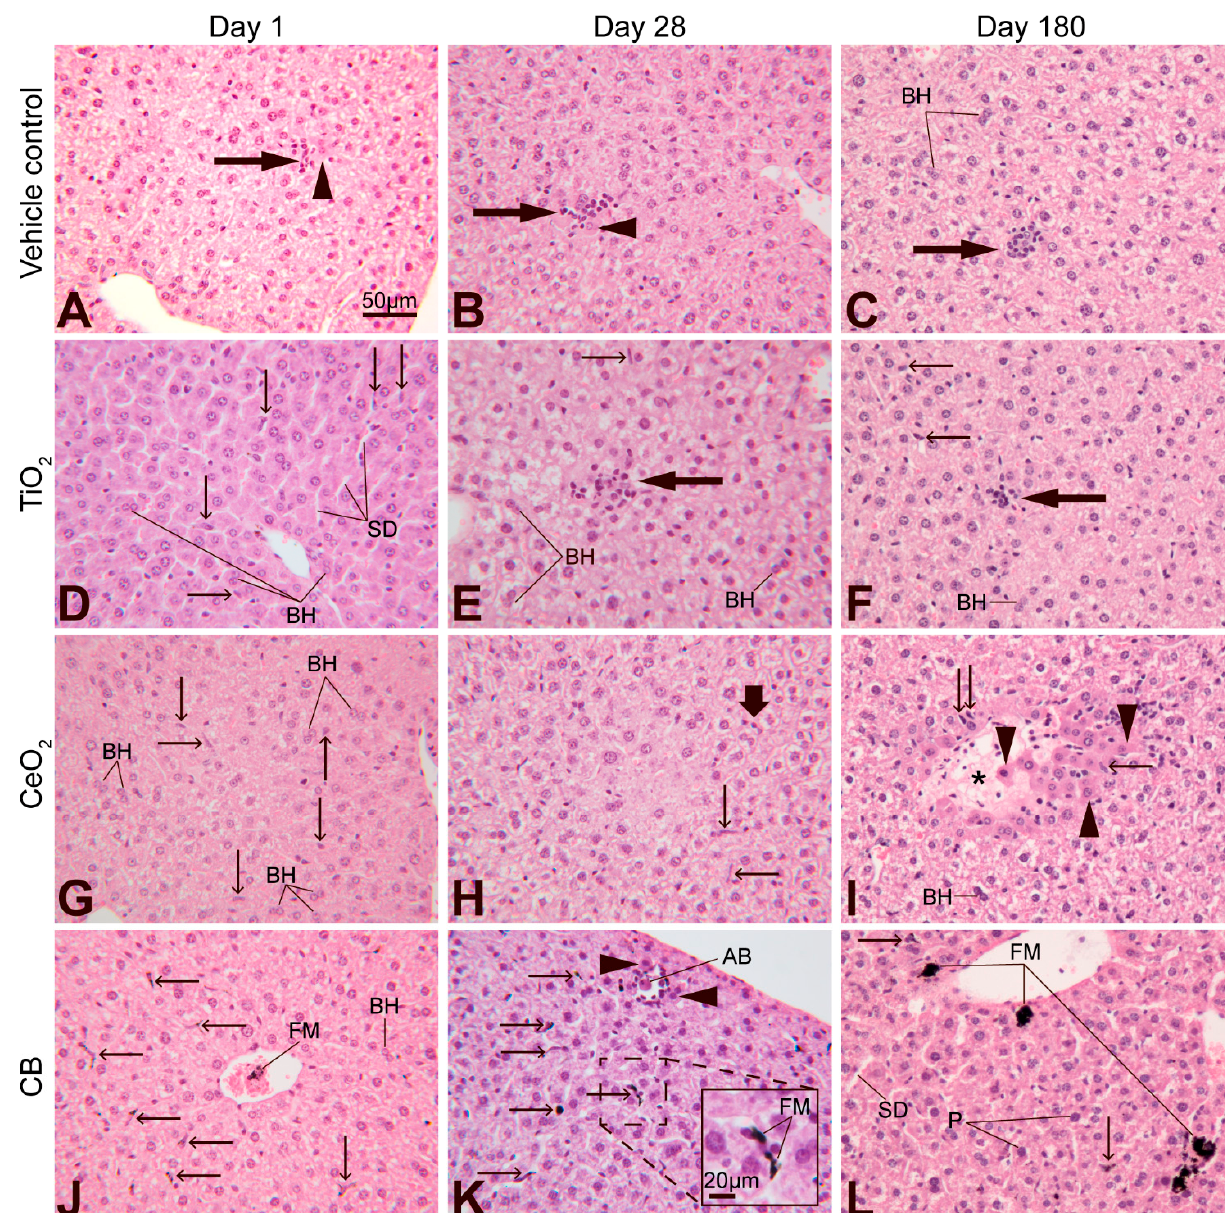
Figure 1. Liver tissue 1 and 180 days after intravenous (IV) or intratracheal (IT) exposure to vehicle control ( A – C ), TiO 2 ( D – F ) and CeO 2 ( G – I ) nanoparticles. Enhanced darkfield microscopy. ( D , G ): Agglomerates of foreign material (white) were distributed across liver sections 1 day after intravenous exposure and often appeared phagocytized by Kupffer cells (inserts in ( D , G )). ( E , H ): 180 days after intravenous exposure, material was accumulated in fewer and larger agglomerates. ( F , I ): Agglomerates seen 180 days after intratracheal instillation were small and much less frequent (arrowheads). Scale bars in A and in the insert in D apply to all images.